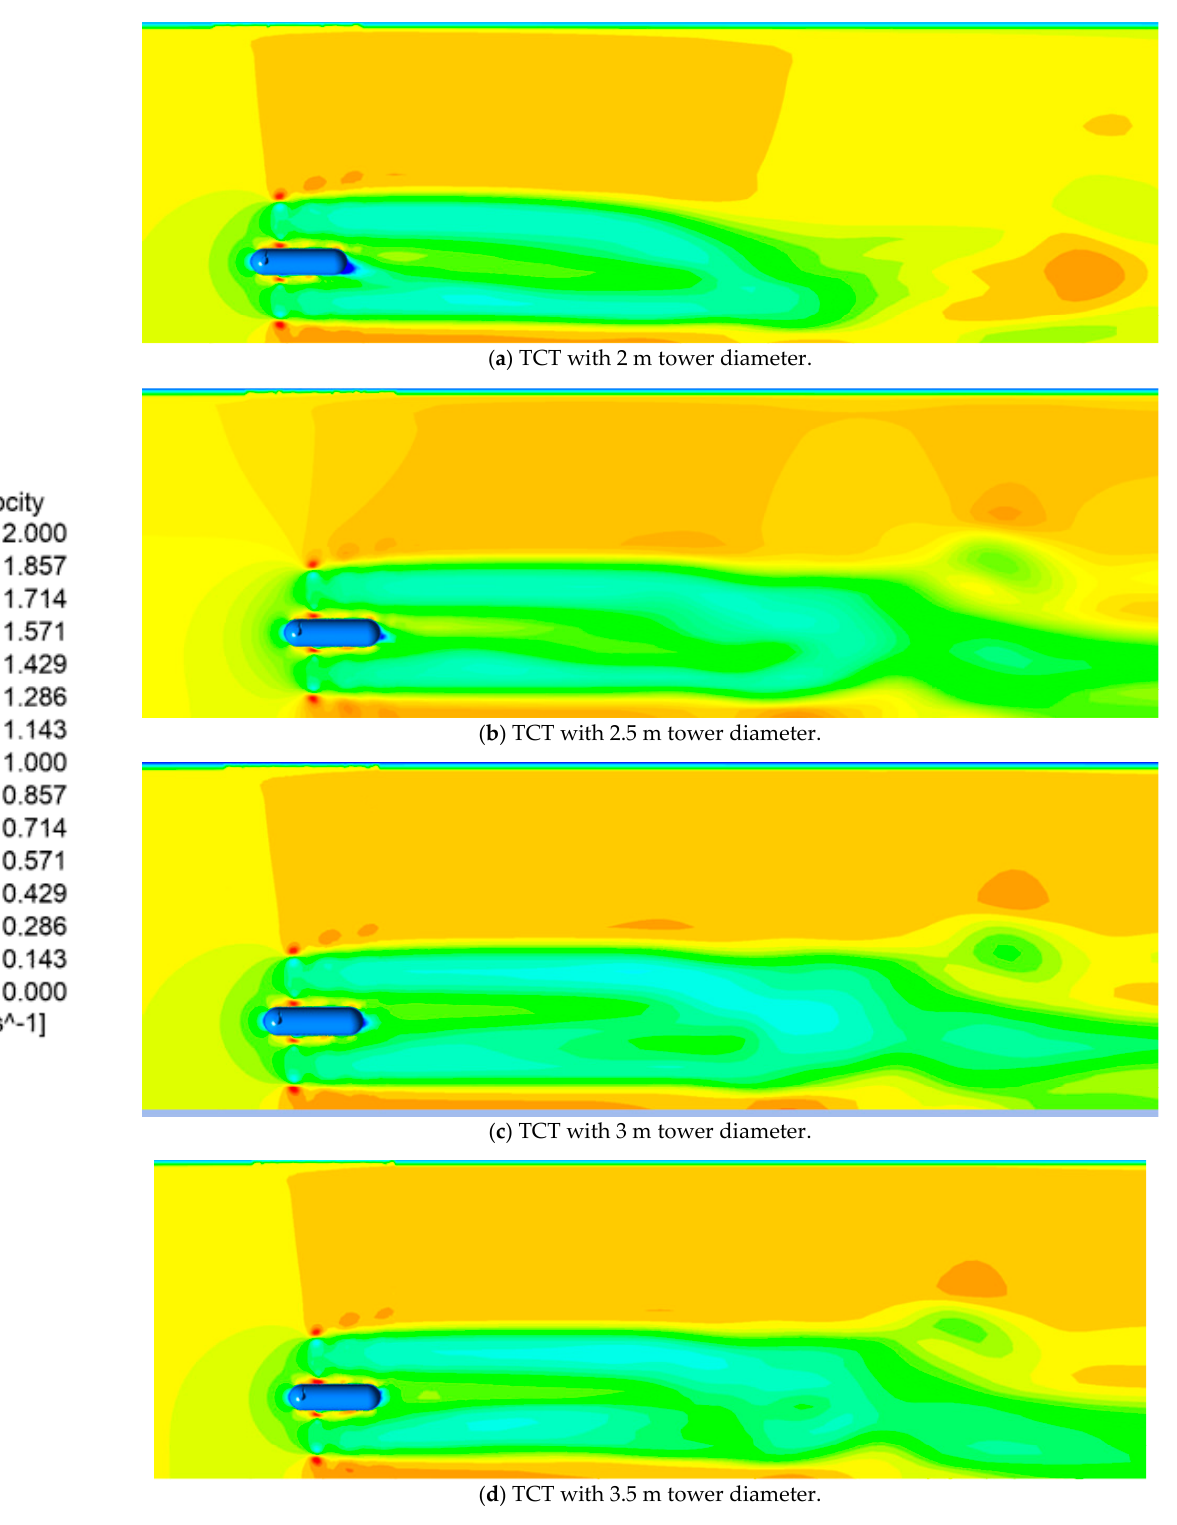
Figure 9. Velocity contour of the water for different tower diameter in the Z-X plane.